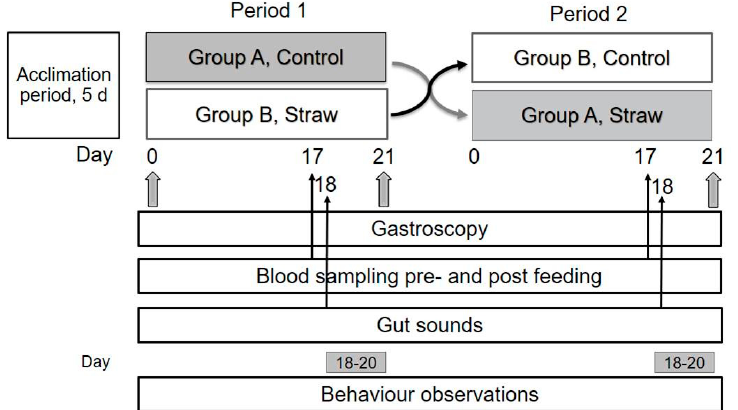
Figure 1. Illustration of the cross-over study design (three horses in group A and B, respectively, that shifted diets from period 1 to 2). Days for data collection in each period are illustrated by the numbers and arrows. Periods were following each other with no days in between. The gastroscopy performed on Day 0 was used to make group A and B as equal as possible with respect to initial ulcers scores.